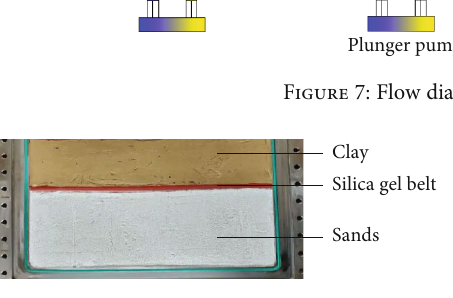
Figure 8: Experimental reservoir thickness.